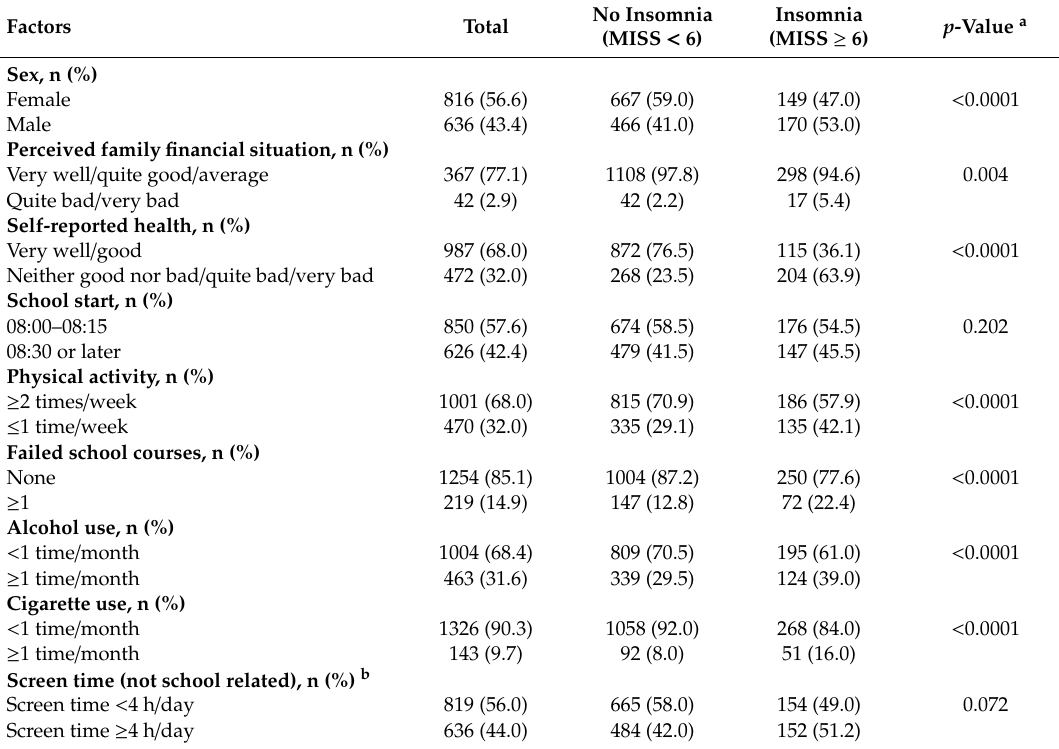
Table 1. Associations between insomnia (MISS ≥ 6) and other factors among adolescents aged 15–17 years (n =